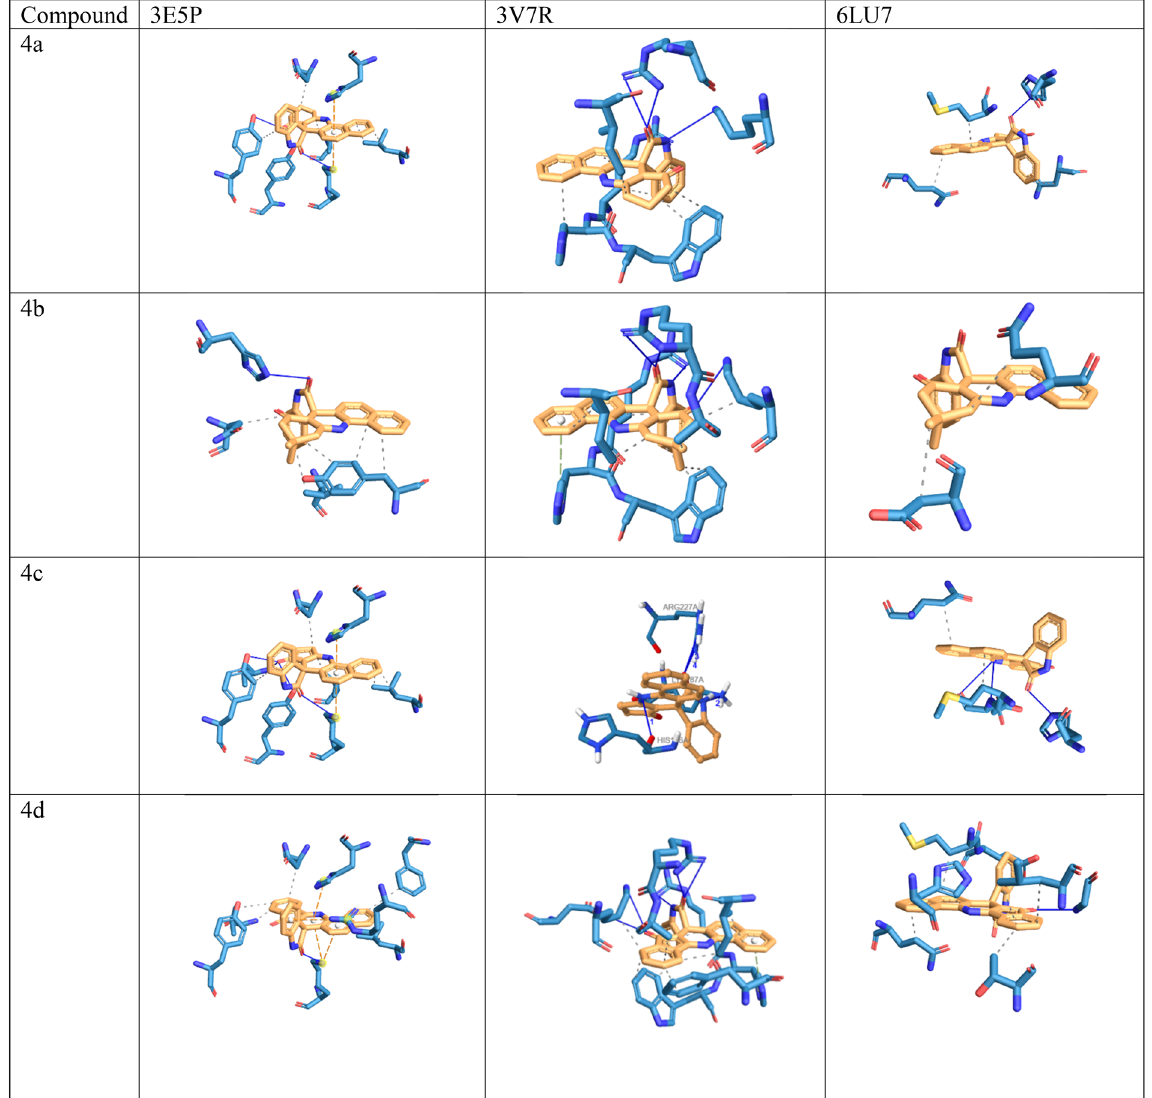
Figure 8. Docking possition of compounds 4a–h, 6a–h in the active site of 3E5P, 3V7R,